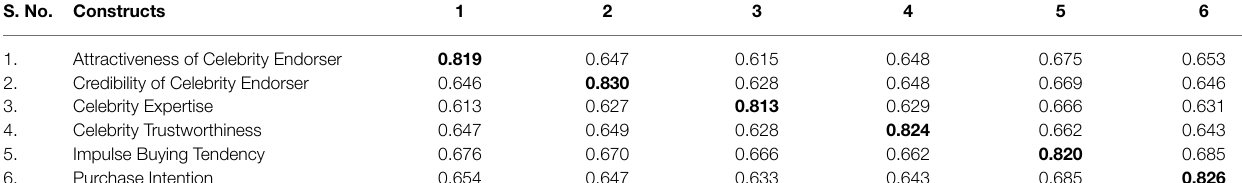
TABLE 3 | Discriminant validity analysis (Fornel Larcker and HTMT).